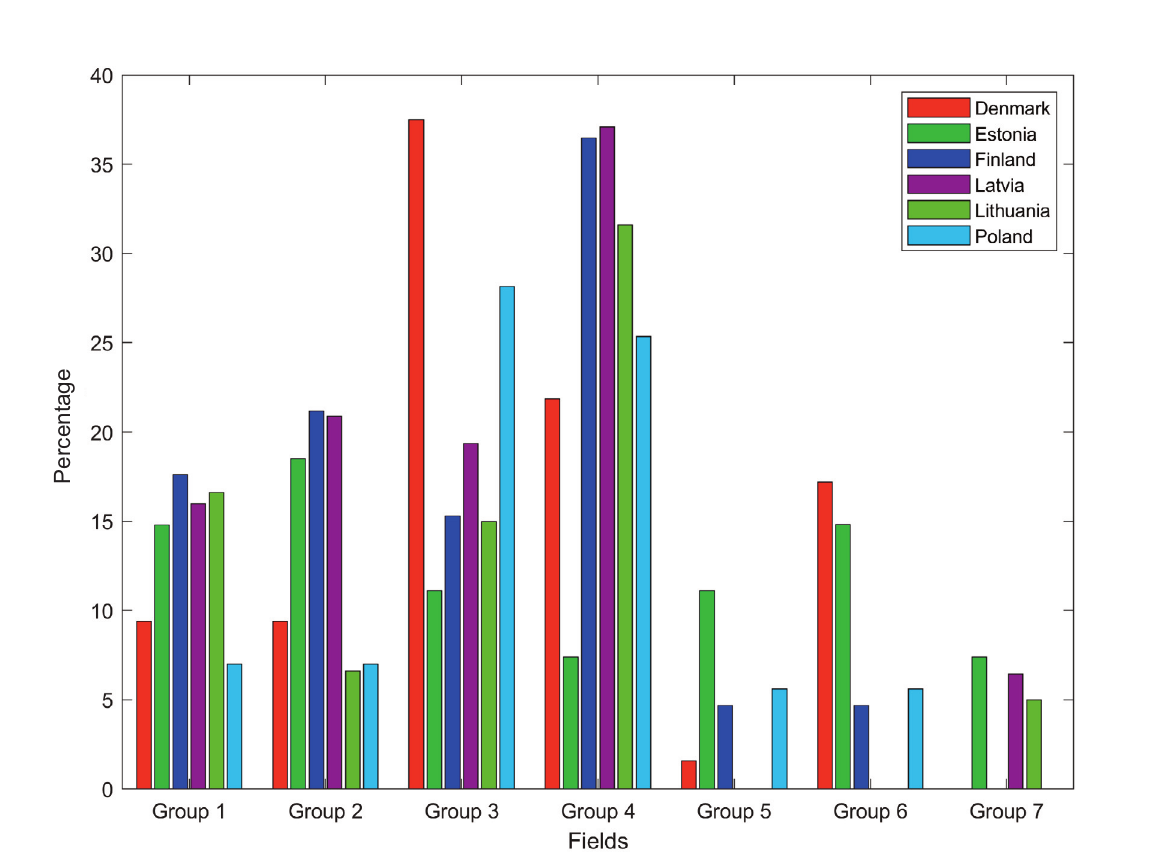
Fig. 3. Comparison of the fields of activity in each